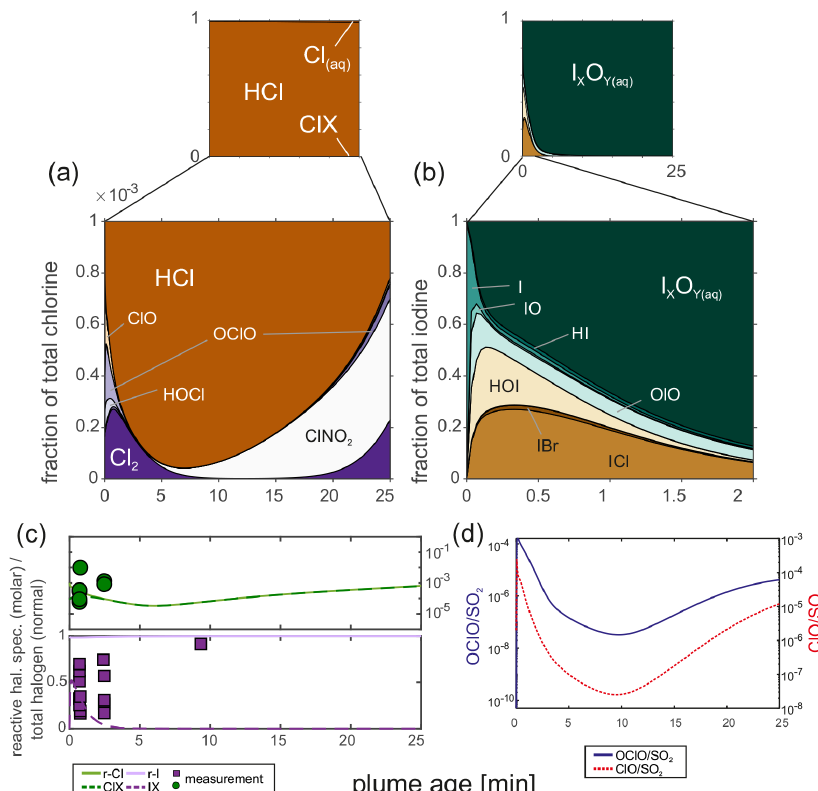
Figure 9. (a) Chlorine and (b) iodine speciation of the base model run (10:90; 30ppmv SO 2 ; air; 10min; 3 × 10 9 particlesm − 3 ; r = 3 × 10 − 7 m); (c) comparison of the measured and modeled reactive halogen to total halogens; (d) molar OClO / SO 2 and ClO / SO 2